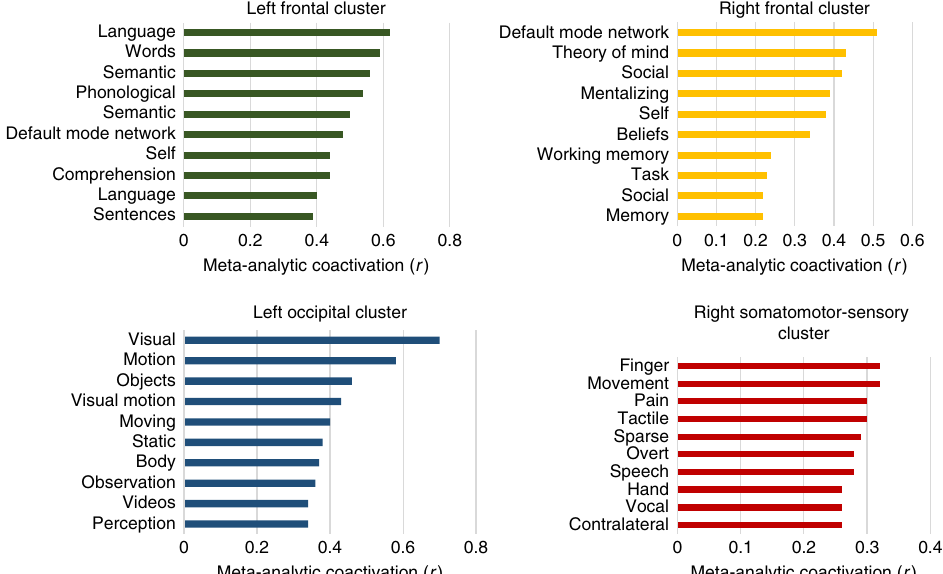
Fig. 6 Functional anatomy of cortical thinning in PD. Peaks within each cluster were associated with expressions used in publications using Neurosynth. The x axes represent correlation values between the cluster and each concept ’ s meta-analytic map generated using seed-based networks. The y axes represent the most highly correlated concepts per